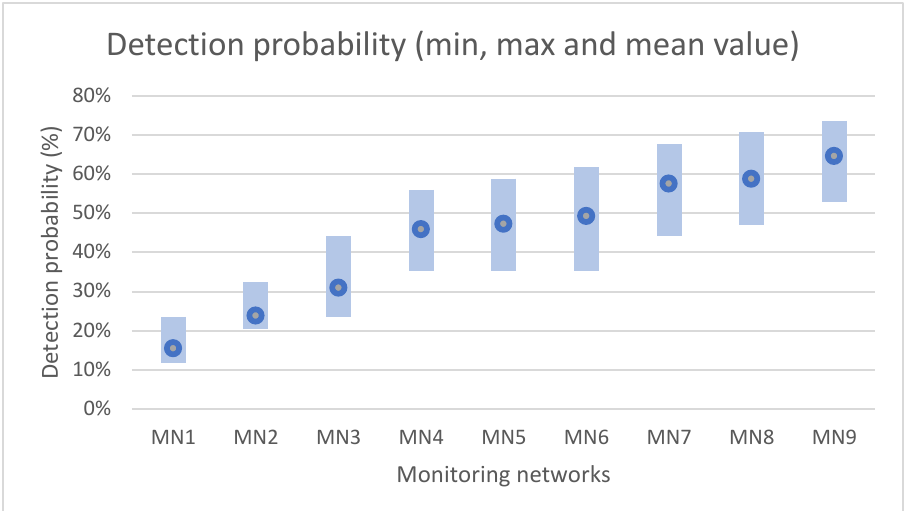
Figure 4. Detection probability minimum, maximum and mean values for monitoring networks (consisting of nodes for installation of sensors based on Ο 4 objective).